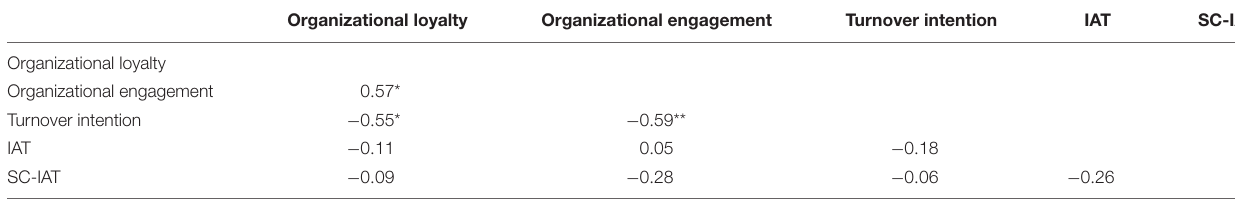
TABLE 5-2 | Correlation of assistant manager.